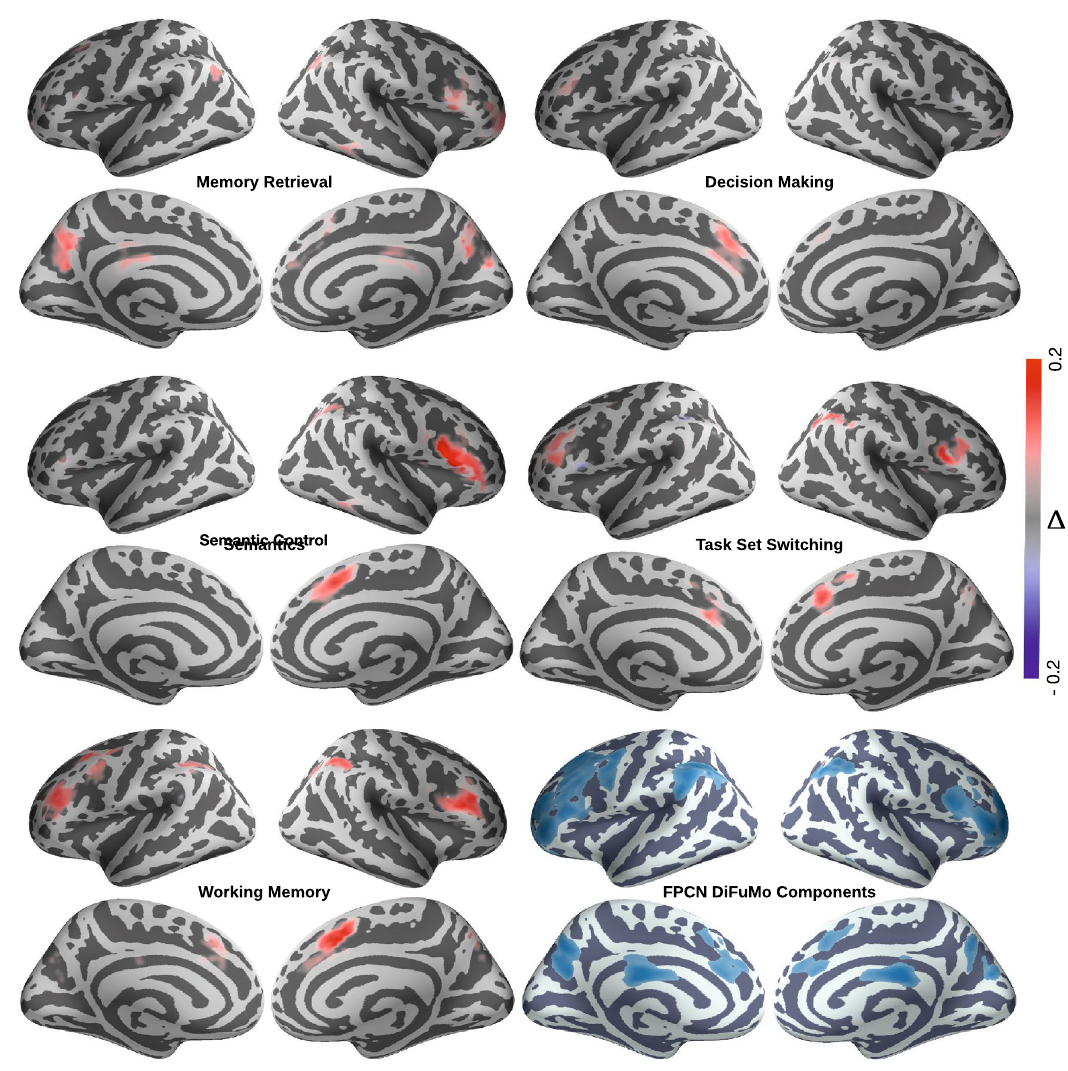
Figure 3. Cortical maps showing the difference in posterior probabilities of FPCN regions to be active given topic segregation and when given no topic segregation queries. We mask out brain voxels that are not part of the FPCN. The difference between posterior probabilities is defined as � = P [ VoxelReported ( x , y , z ) | SingleTopicAssociation ( t ) ]− P [ VoxelReported ( x , y , z ) | TopicAssociation ( t ) ]